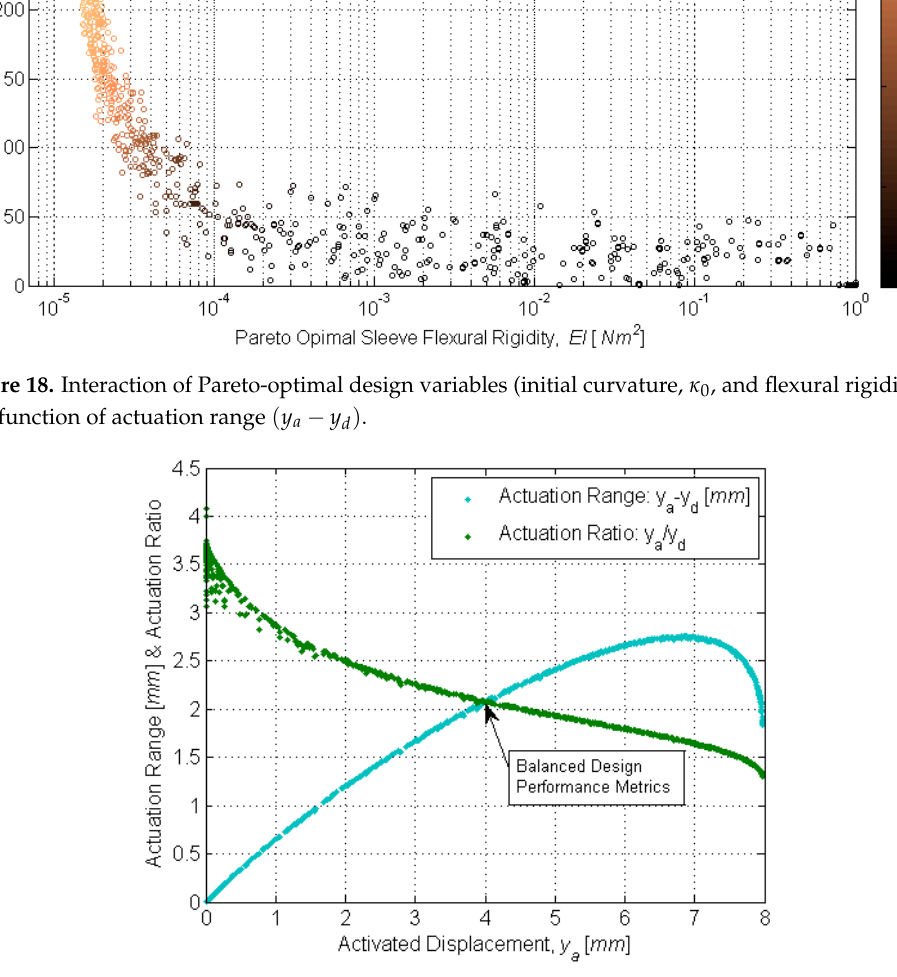
( ) y y and change in a d y . a